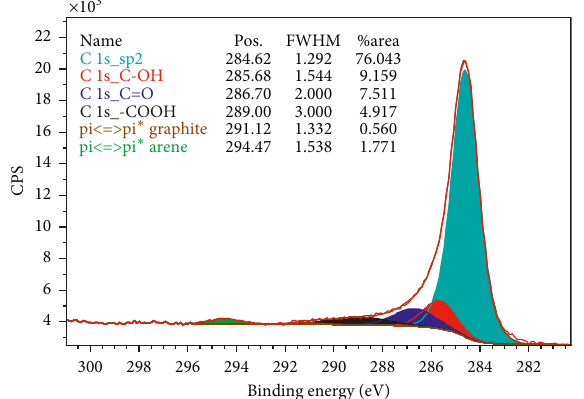
Figure 9: High-resolution photoelectron spectra of the C 1s sublevel.